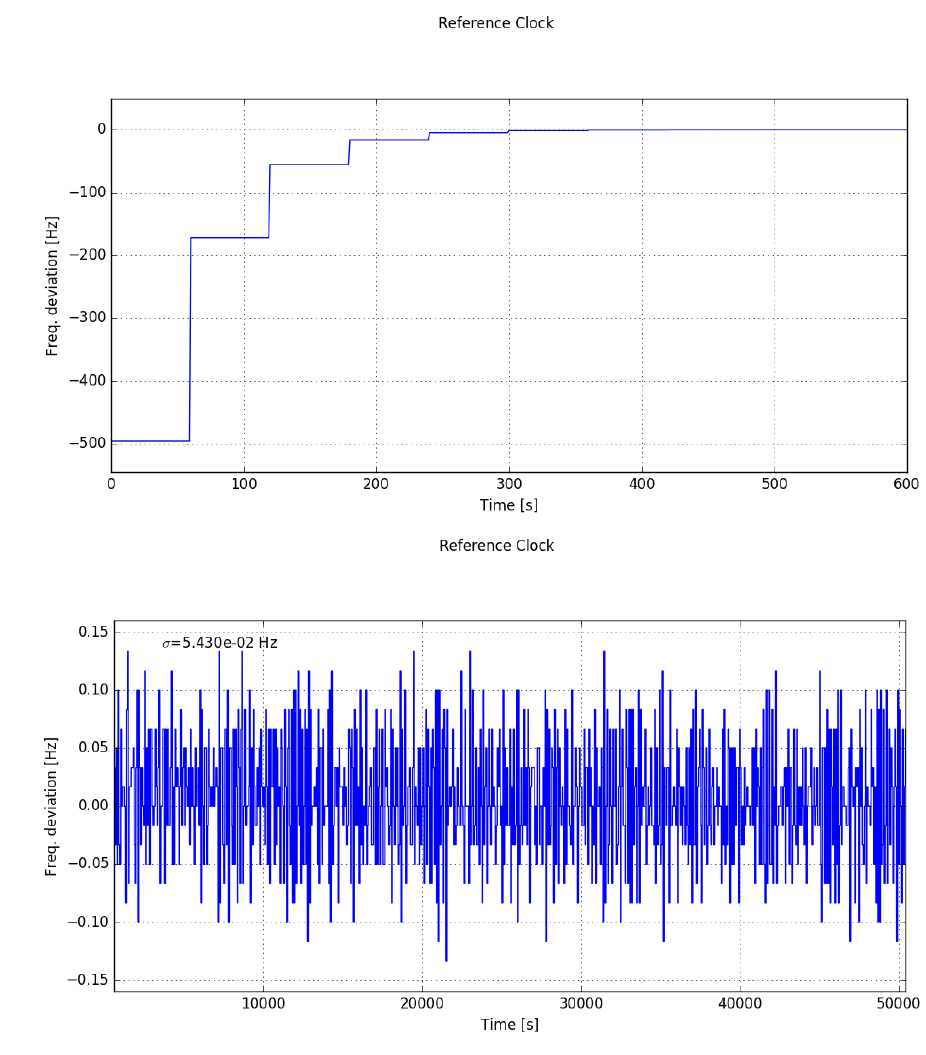
Figure 10. Deviation of the system reference frequency with respect to the nominal value. Top : initial convergence period of less than 10 min. Bottom : stabilized clock during 14